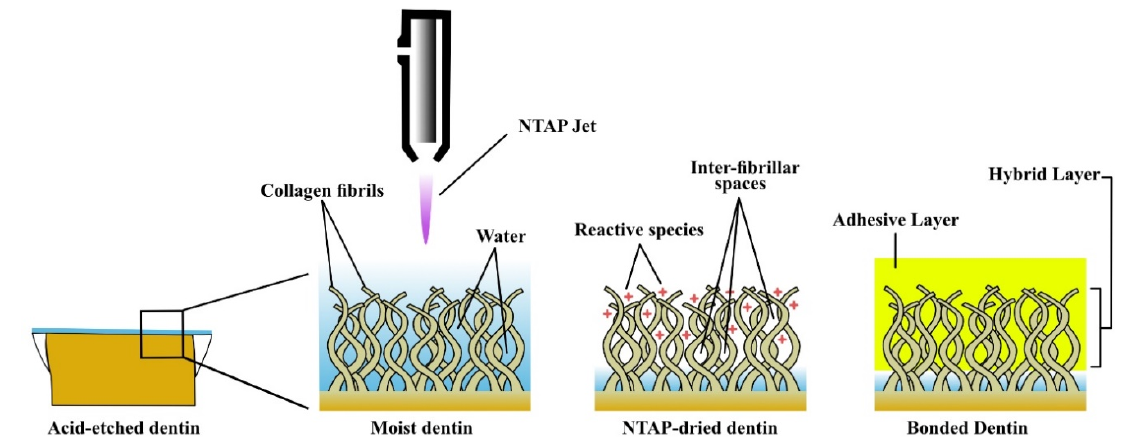
Figure 2. The effect of non-thermal atmospheric plasma (NTAP) on adhesive resin–dentin bonding in etch-and-rinse (ER) mode.